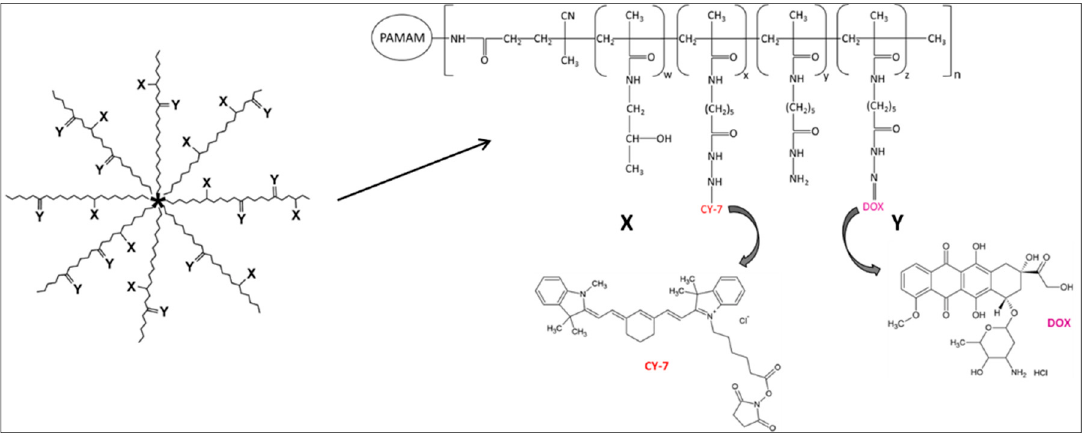
Scheme 1. Structure of the pHPMA-Dox-Cy7 conjugate.